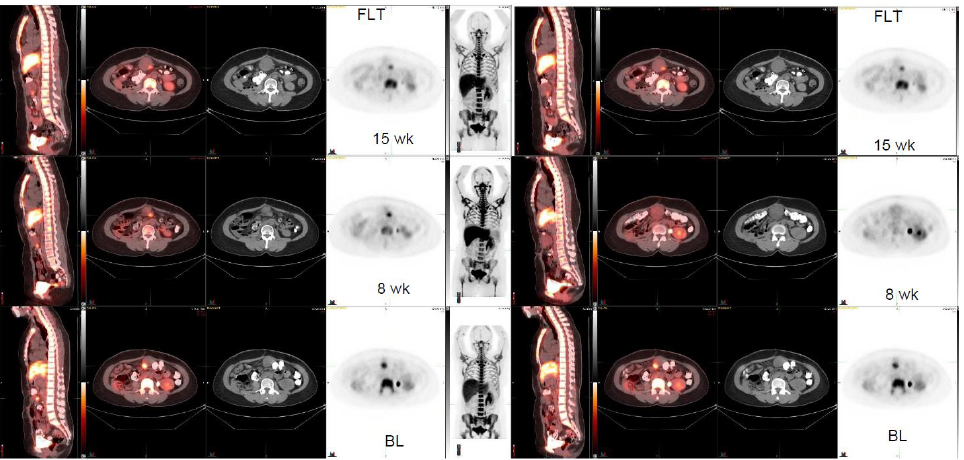
Figure 2. Liposarcoma. FLT-study at baseline, at 8, and at 15 weeks (3 rows). Anterior peritoneal mass is seen; the tumor consists of three components, which are in connection. The biggest tumor changes on CT as follows: 4.1 cm × 3.2 cm ->5.5 cm × 4.1 cm->5.6cm × 5.2 cm. FLT-uptakes changes in the most active site as follows: SUVmax 5.8 ->4.2 -> 3.5.